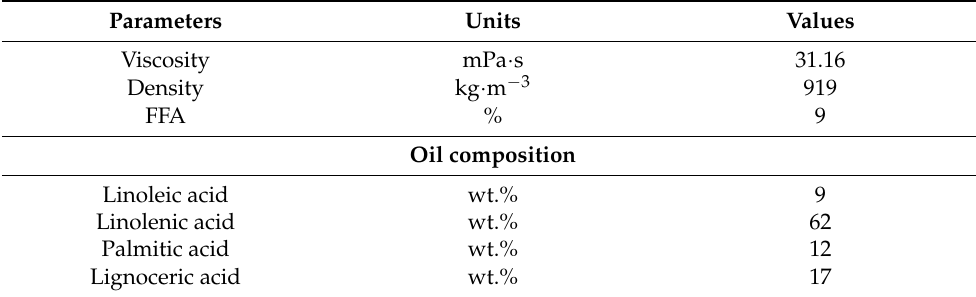
Table 1. WCO properties and its oil